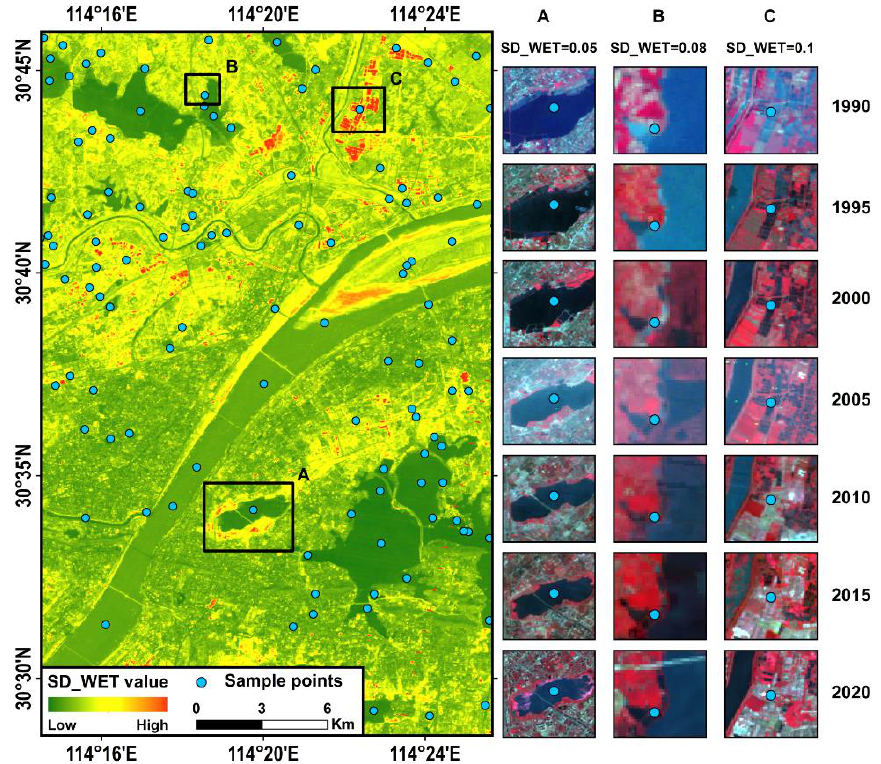
Figure 3. Example of the spatial distribution of SD_WET. ( A – C ) demonstrate the land cover change in the areas with different SD_WET values between 1990 and 2020.